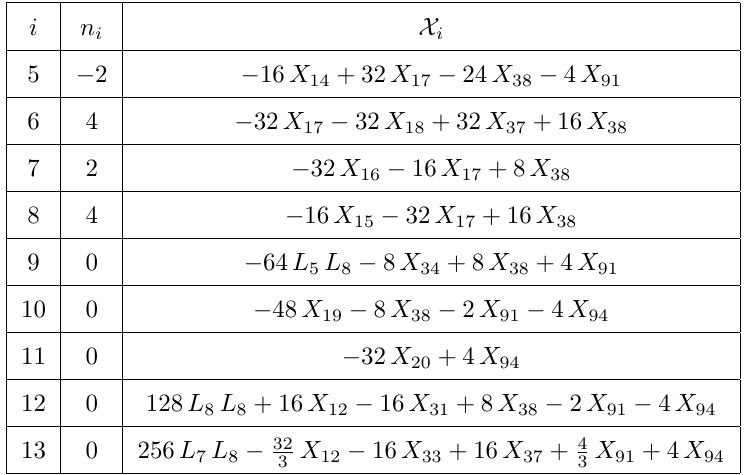
Table 10 . Parameters n i and X i entering the prediction of the LECs ( g 8 N i ) 1 in eq.